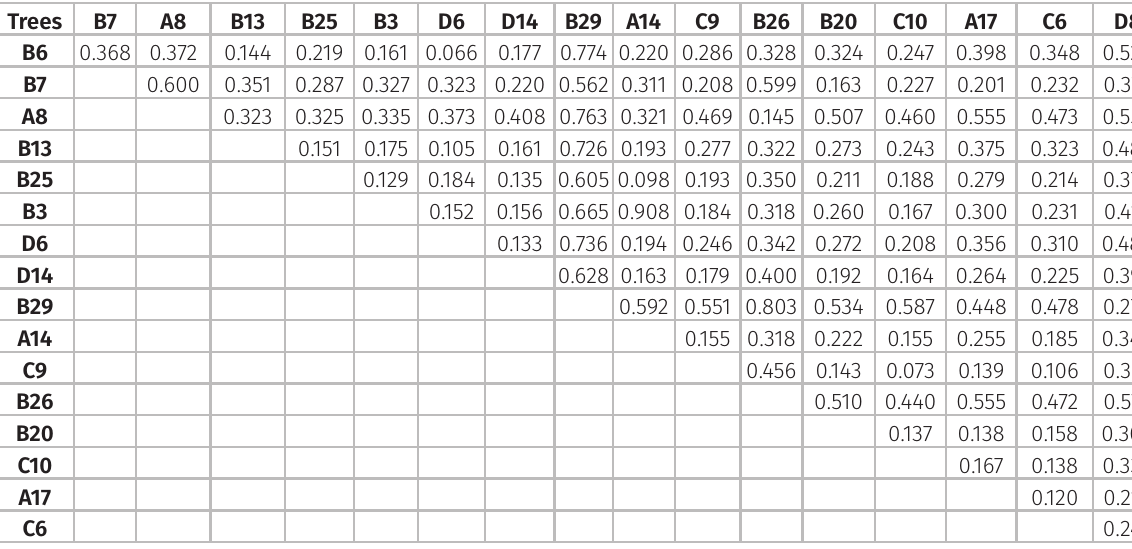
Table II. Genetic dissimilarity matrix based on the Euclidean distance of the 17 trees of Caryocar brasiliense with and without thorns at the endocarp, cultivated at Água Limpa Experimental Station - UFU, Uberlândia, MG, Brazil, 2017/2018.